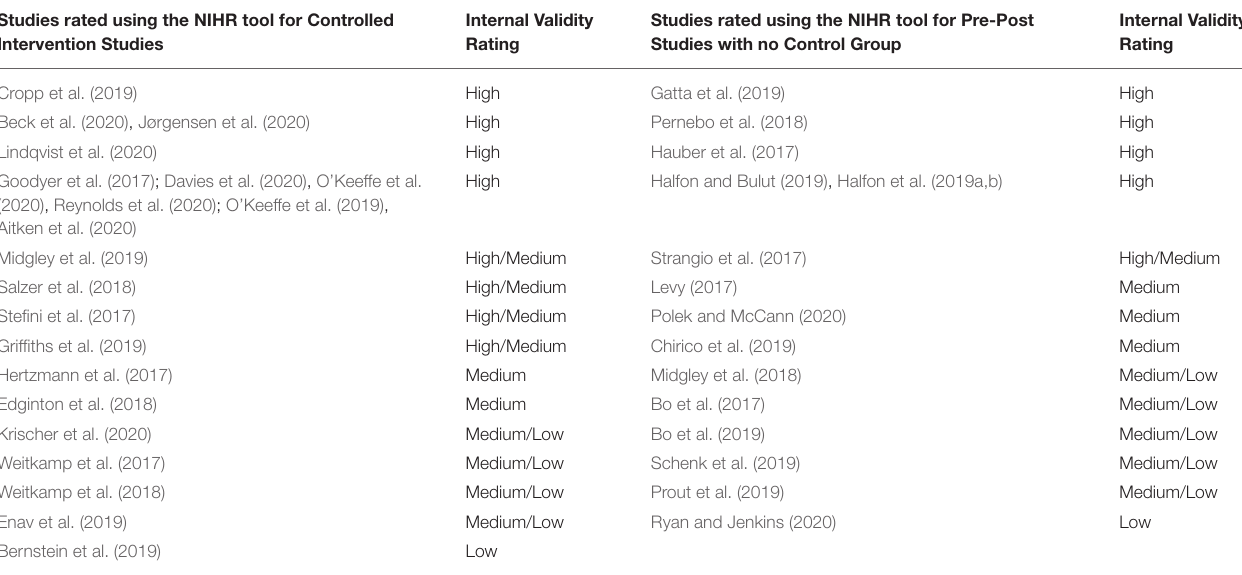
TABLE 2 | Studies 2017–2020 grouped by Internal Validity (Risk of Bias)